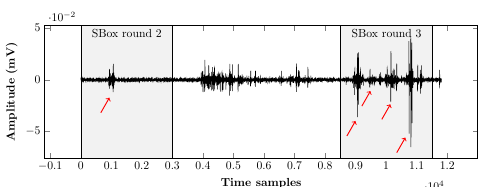
Figure 1: Differential power trace showing leakage at Sbox in round 2 and round 3 of AES -128 on 8-bit AVR microcontroller. Highlighted parts show how 1 byte difference propagates into 4 bytes.